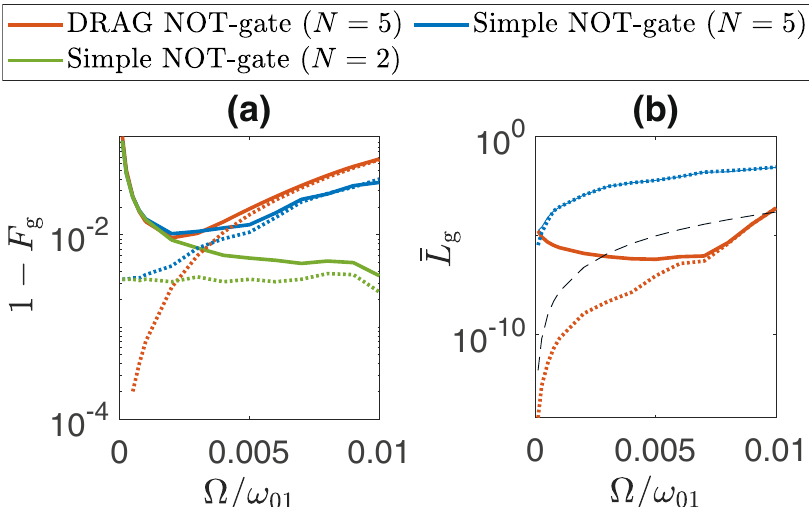
Fig. 9 Comparison of the in fi delities and the state leakages. a The average in fi delity of the simple and DRAG NOT gates. b Average state leakage for the simple and DRAG NOT gates. The black dashed lines represents the curve for Ω 4 / α 3 . We have used E J / E C = 100, β ℏ ω 01 = 10, κ = 10 − 5 ω 01 (solid lines) and κ = 0 (dotted